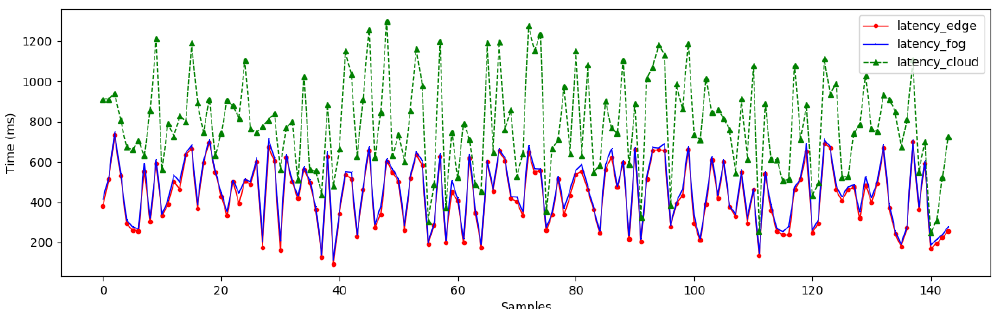
Figure 8. Latency Patterns.